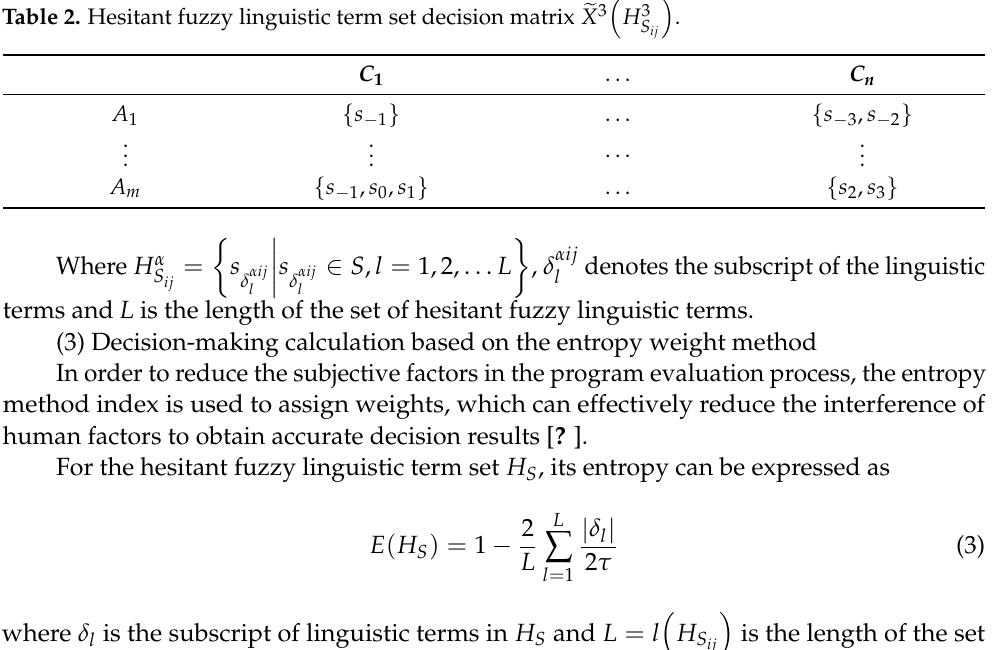
(cid:17) (cid:16) H 3 . S ij